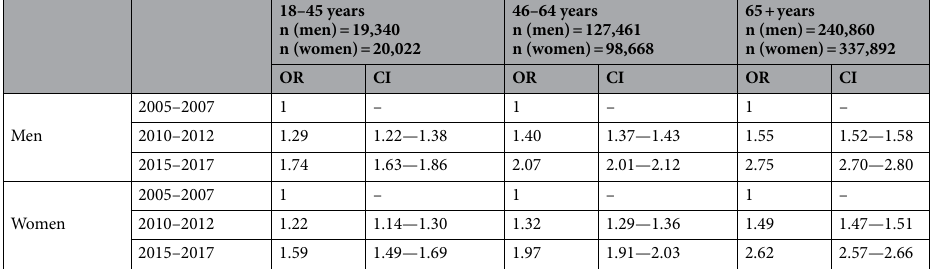
46–64 years n (men) = 127,461 n (women) =